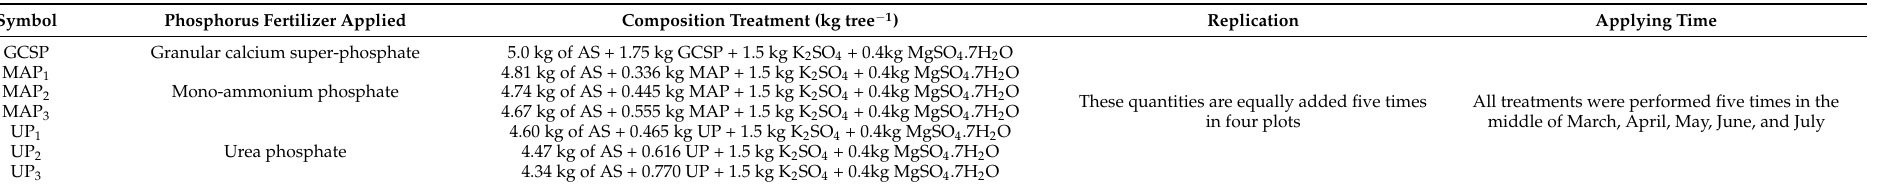
Table 2. Details of the treatments applied in this study: phosphorus fertilizers applied, composition of treatments, replications, and application times on olive trees ( Olea europaea L. arbequina cv.) in 2020 and